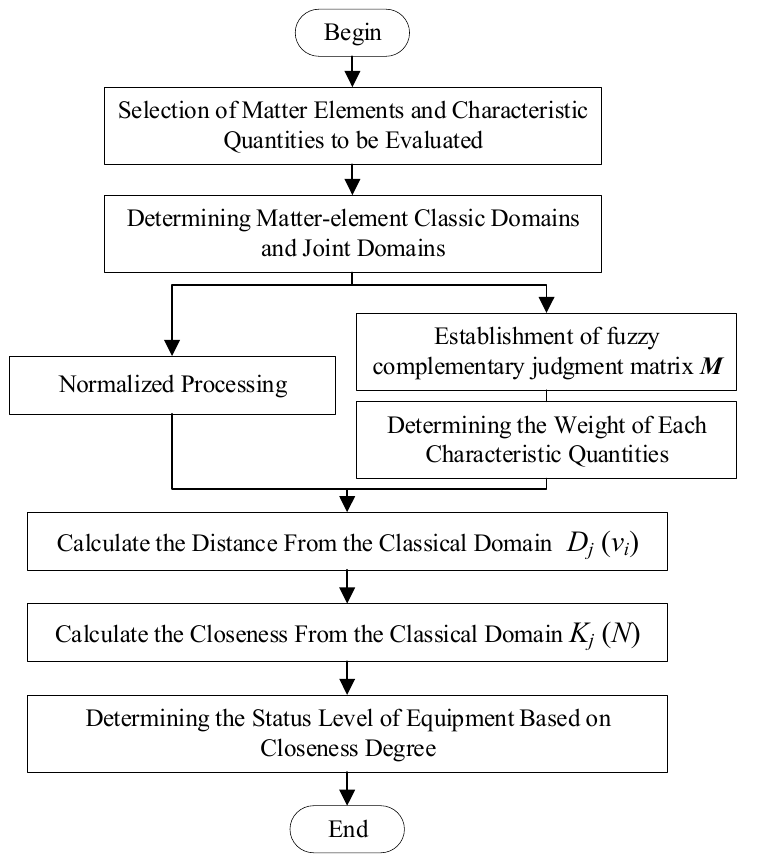
Figure 4. State Evaluation Process of Matter Element Extension Method.